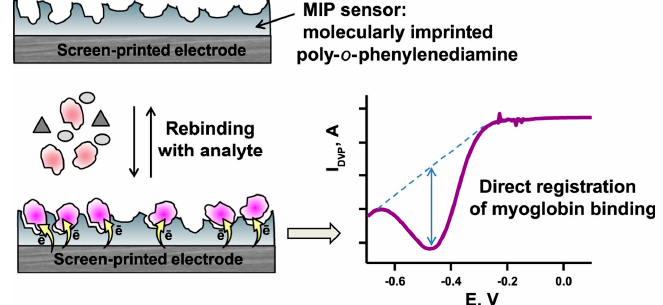
Figure 5. Schema of MIP preparation and the detection of myoglobin binding. Reprinted by permission from [90].